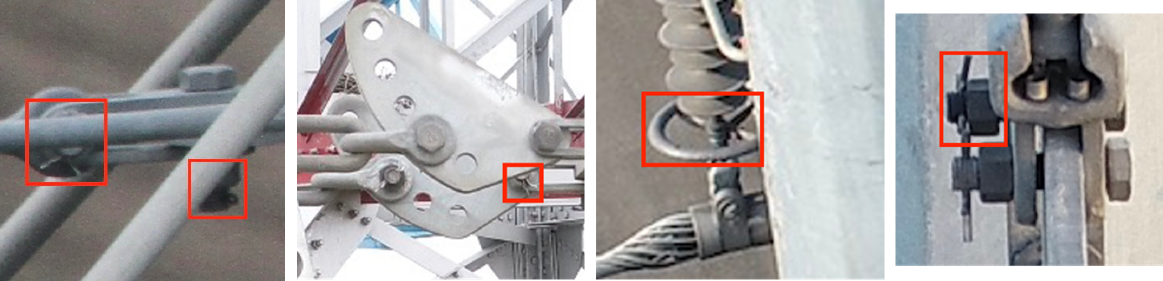
Figure 2. The small-sized and obscured fittings and connecting components.